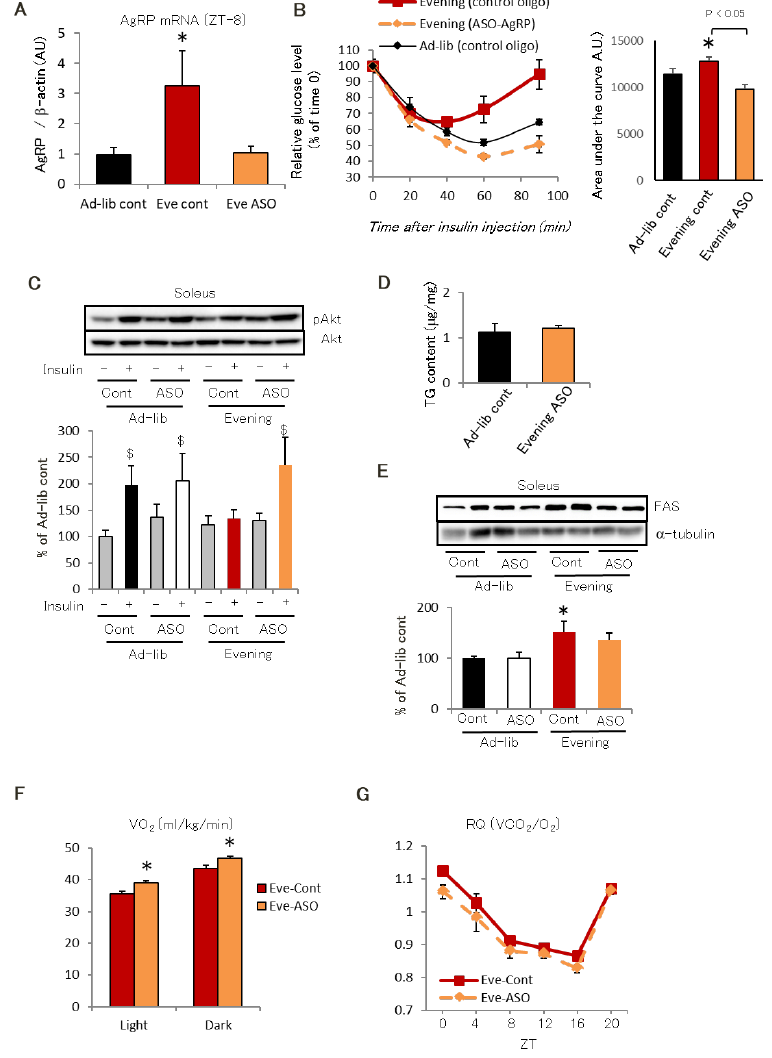
Figure 4. AgRP is responsible for the evening feeding rhythm-induced insulin resistance. ( A ) AgRP mRNA expression in the hypothalamus after intracerebroventricular antisense oligonucleotide (ASO) administration (twice a week) in the Evening group. ( B ) insulin tolerance test (ITT). ( C – E ) Akt phosphorylation in soleus ( n = 3) ( C ), TG content in gastrocnemius ( n = 6) (D), FAS expression in soleus ( E ) following ASO treatment. ( F and G ) VO 2 in the dark and light period (F) and circadian RQ over 24 h ( n = 6) following ASO treatment in the each Evening group. Data are presented as mean ± standard error. * p < 0.05 vs. Ad-lib group. $ p < 0.05 vs. Akt phosphorylation of each group without insulin.